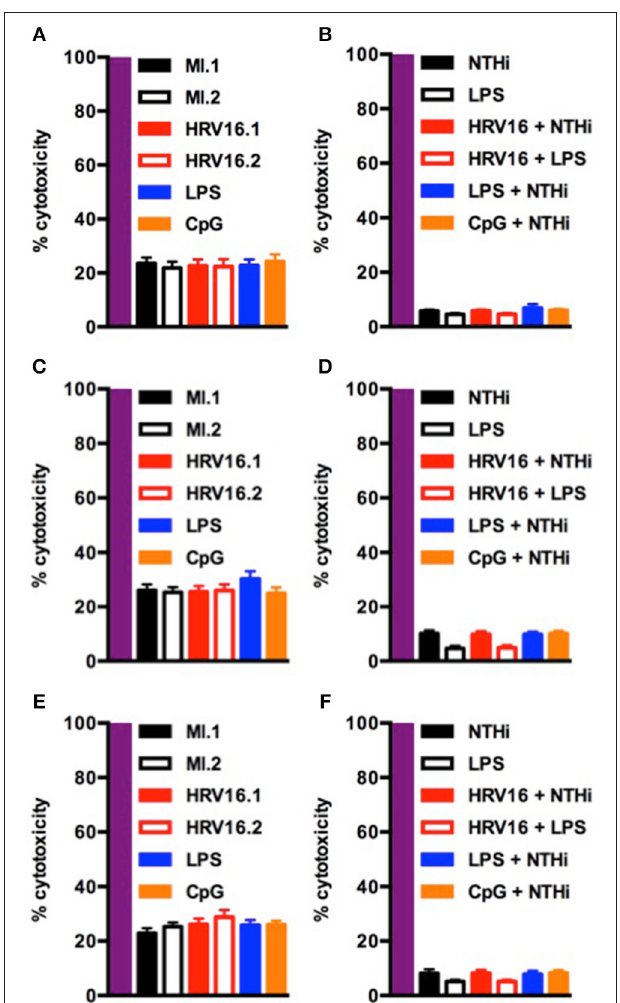
FIGURE 7 | Human macrophages exposed to HRV16 do not display increased cytotoxicity. Human macrophages were exposed to HRV16 (red bars), LPS (blue bars), CpG (orange bars) or MI (black bars) for 1h and rested overnight, for 48 or 72h. Then they were exposed to NTHi or LPS for 2h. Supernatants were collected and analyzed by an LDH assay. LDH results for (A) 24h, (B) 24h + 2h NTHi or LPS, (C) 48h, (D) 48h + 2h NTHi or LPS, (E) 72h, (F) 72h + 2h NTHi or LPS. All results are expressed relative to total lysis (purple bars). n = 4 independent experiments on different donors.